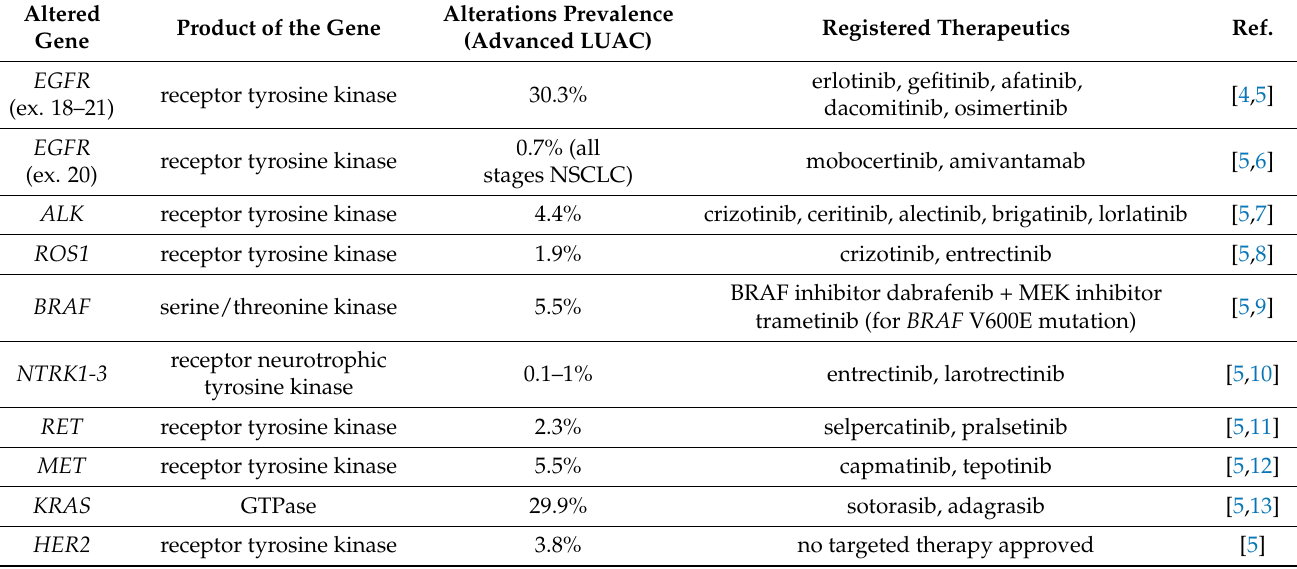
Table 1. Oncogenic driver genes and corresponding targeted therapies for NSCLC patients currently used in the clinic (approved by FDA and/or